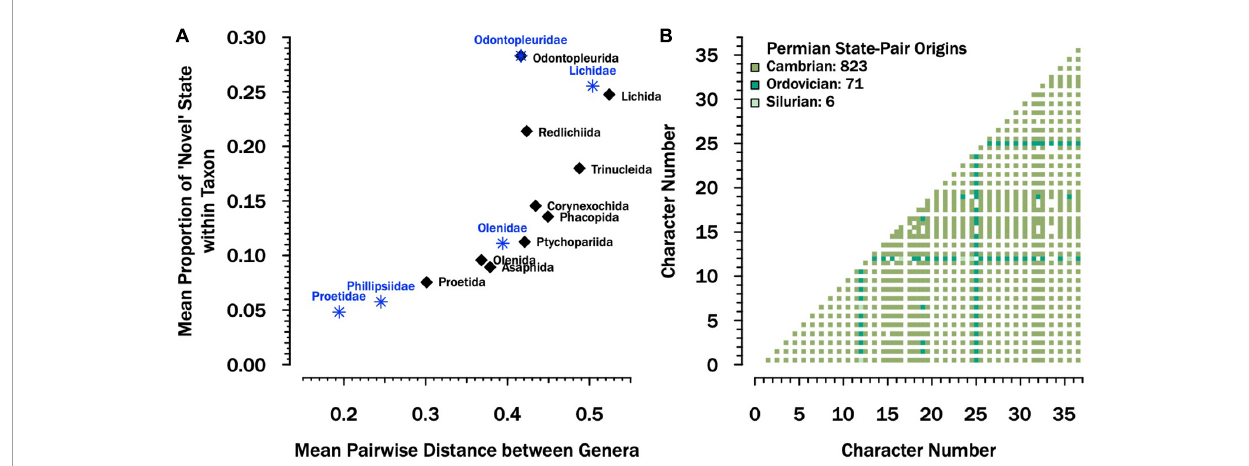
FIGURE2 Disparity across the exoskeleton. (A) Scatterplot showing the average proportion of unusual traits (those coded as “1” in the matrix) compared to the average pairwise distance within orders (black dots) and families with more than 5 sampled genera (blue asterisks). Here “Proetidae” consists of non-phillipsiid taxa. The taxonomic status of “Phillipsidae” is debated, but it is currently thought to be a subclade within the Proetidae (Vanderlaan and Ebach, 2015). Together, they comprise 67% of the genera assigned to order Proetida in the character matrix. See Supplementary material for details about sampling, coding, and summary statistics presented here. (B) Combinations of paired states from the character matrix that are observed in Permian taxa (lower triangle), color-coded by the previous period in which the pair is observed in other trilobite taxa. The majority (80%) are first observed in the Cambrian; the rest are first observed in either the Ordovician or Silurian and none of them are novel to the Permian.